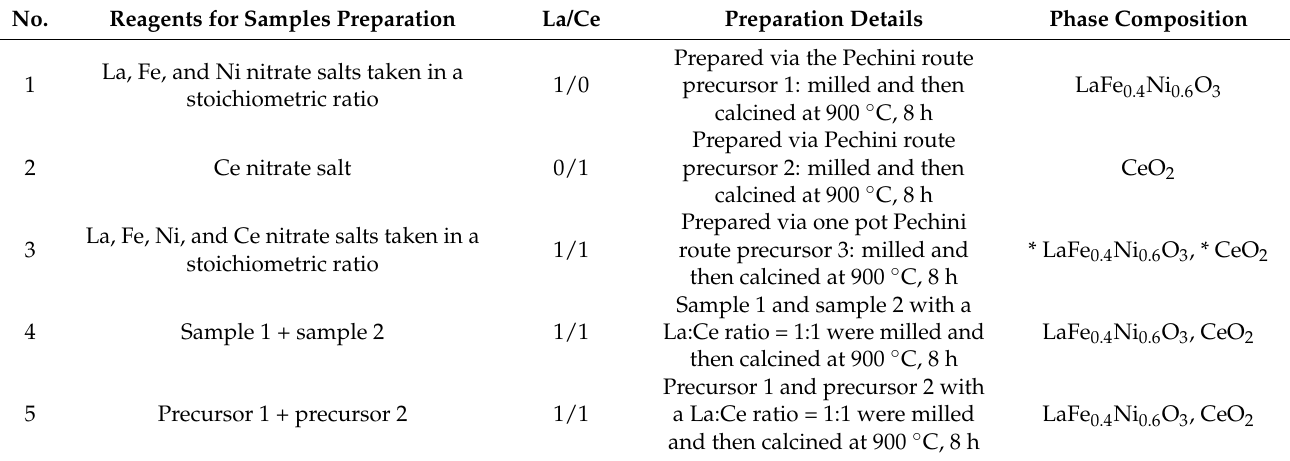
Table 1. Samples preparation